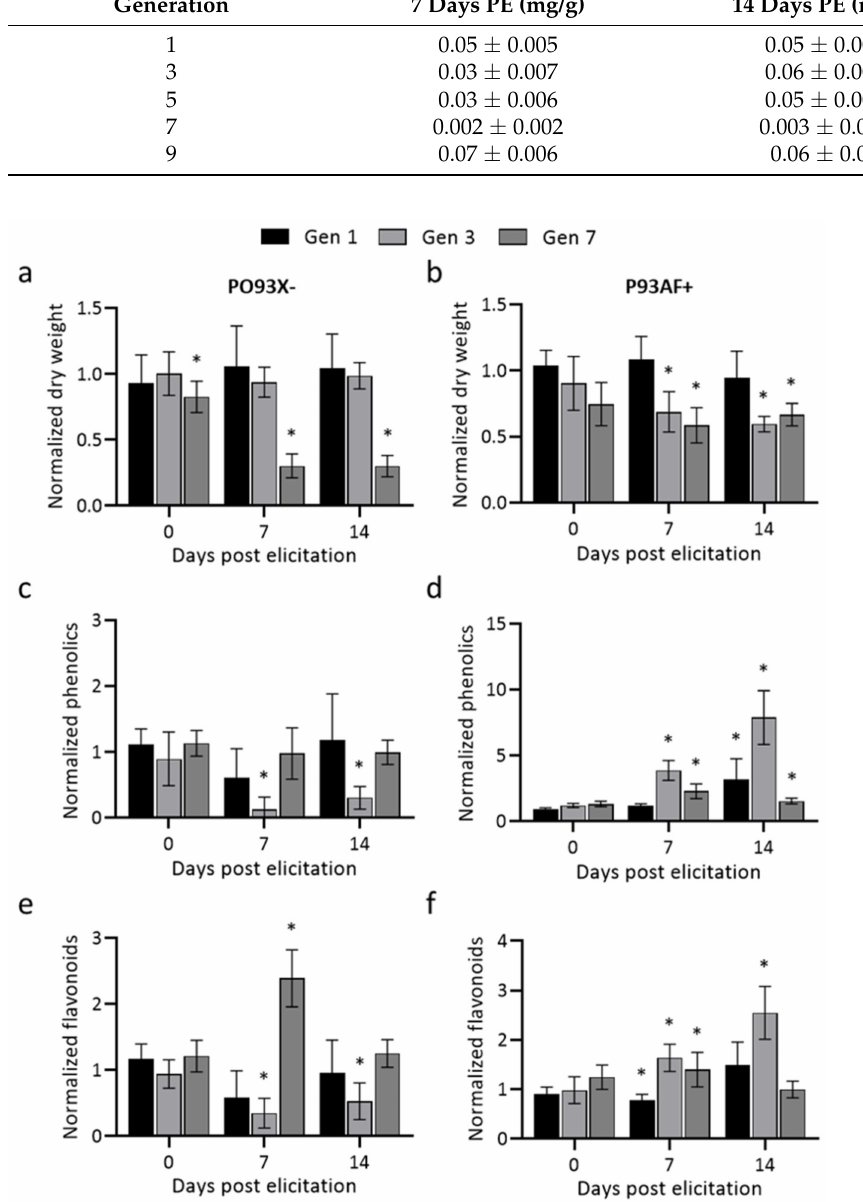
Figure 3. Long-term effect of methyl jasmonate on paclitaxel and non-paclitaxel accumulating Taxus cultures. Dry weight ( a , b ), phenolic content ( c , d ), and flavonoid content ( e , f ) were quantified in PO93XC − ( a , c , e ) and P93AF+ ( b , d , f ). These data were normalized to mock elicited controls. ( n = 3 biological replicates, error bars = standard deviation) (Student’s t -test compared to 1, * p <